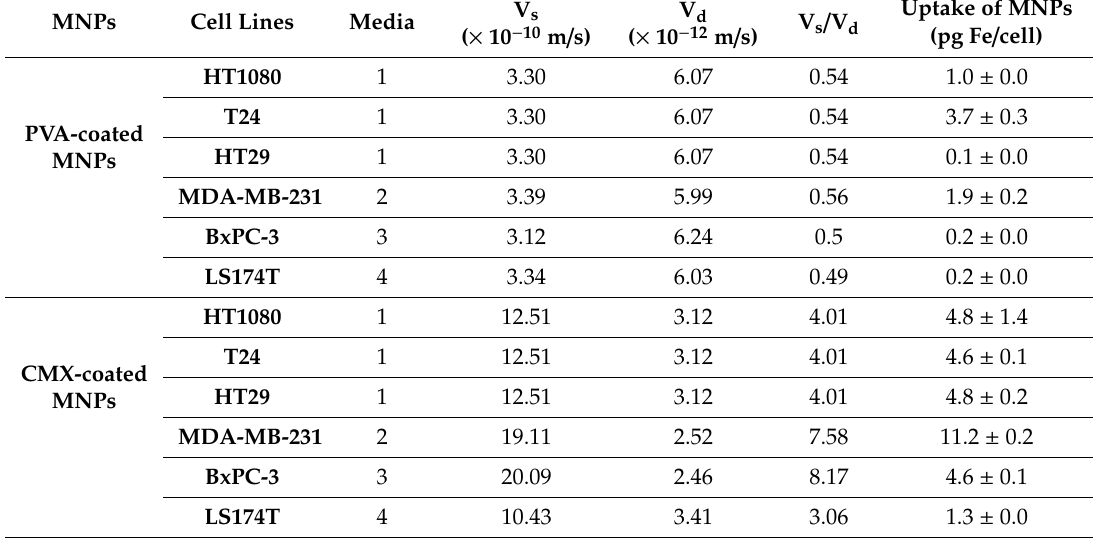
Table 6. Comparing the influence of V s on cell uptake of low and medium clustering MNPs (PVA-coated MNPs vs. CMX-coated MNPs). V s and V d are reported in meter per second (m / s). The uptake amount is reported in picogram iron per cell (pg Fe / cell). Four di ff erent cell culture media were used in this study (defined in the material and method section). HT1080, T24, and HT29 cell lines were cultured